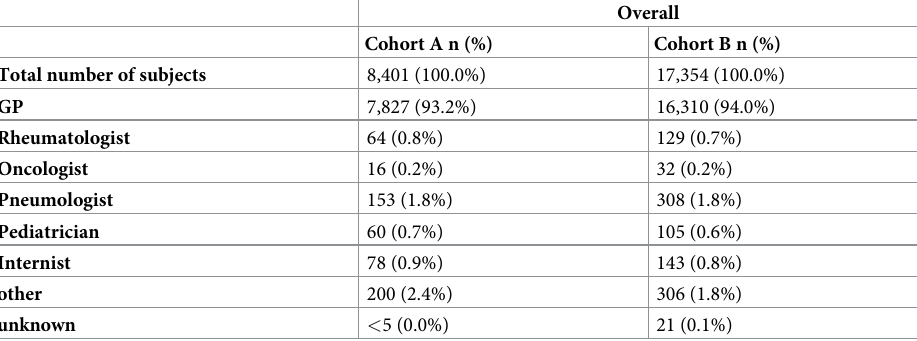
Table 4. Physician administering the vaccination in each